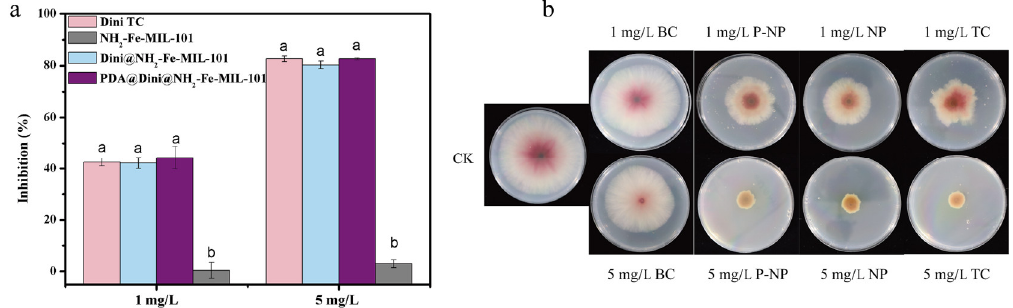
Figure 8. The histograms ( a ) and colony images ( b ) of the fungicidal activity of Dini technical concentrate (TC), Dini@NH 2 -Fe-MIL-101 (NP), PDA@Dini@NH 2 -Fe-MIL-101 (P-NP) and blank carrier of NH 2 -Fe-MIL-101 (BC) against the wheat head scab fungus ( F. graminearum ) at 4 days. Error bars correspond to standard errors of triplicate measurements. Bars marked with di ff erent letters are statistically di ff erent at p ≤ 0.05 as determined by Duncan’s multiple range